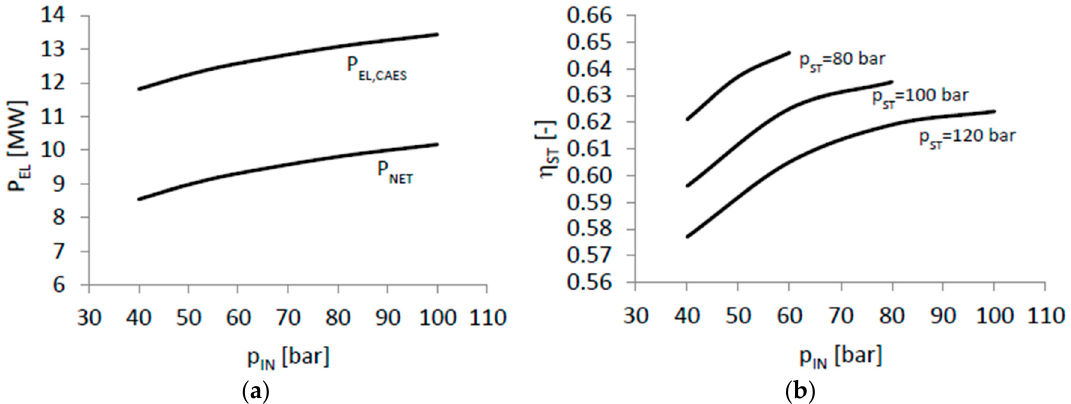
Figure 4. ( a ) Power output actually produced by the AT (cid:1842) (cid:3006)(cid:3013),(cid:3004)(cid:3002)(cid:3006)(cid:3020) and CAES net power output (cid:1842) (cid:3015)(cid:3006)(cid:3021) . versus pressure at the beginning of the charging phase ( (cid:1865) (cid:3008),(cid:3004)(cid:3002)(cid:3006)(cid:3020) = 25.6 kg/s); ( b ) CAES storage efficiency as a function of the pressure at the beginning of the charging phase and the storage